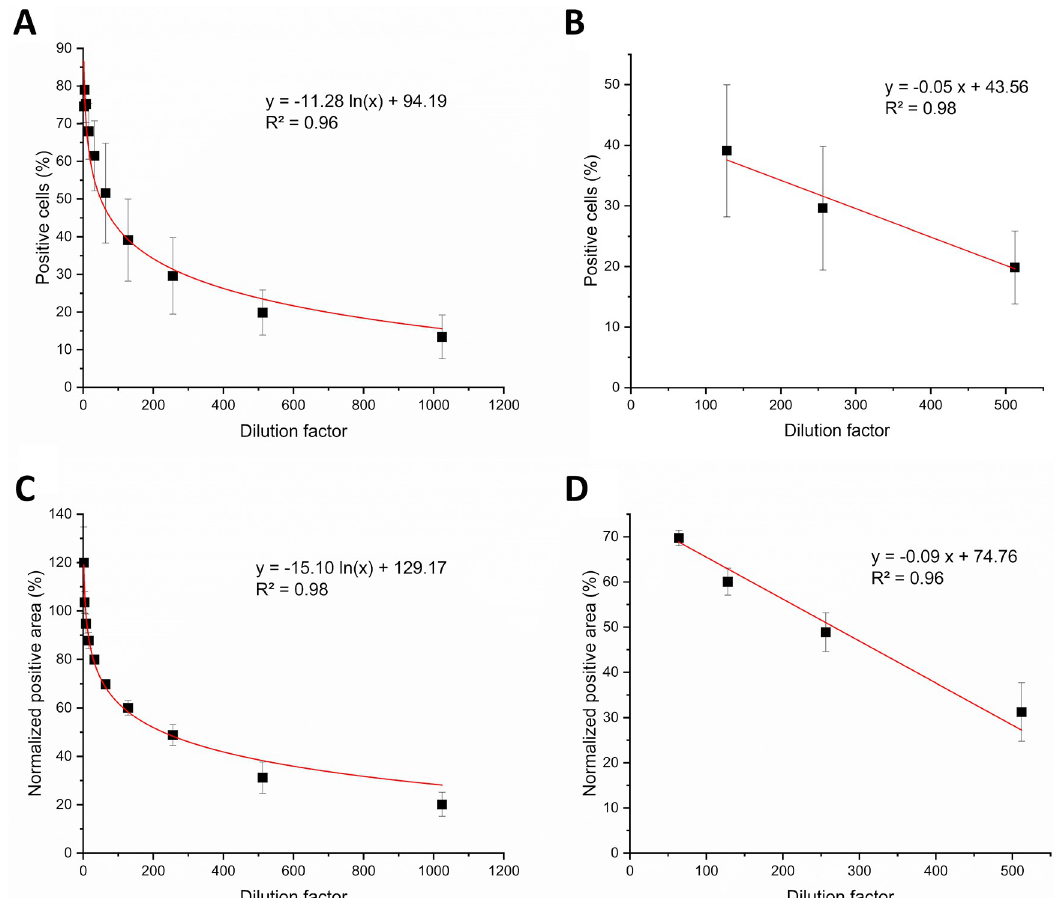
Fig 5. Linear range of the infectious titer assays. The number of positive cells detected via flow cytometry (A & B) and the FabFluor-488 positive area determined with the Incucyte 1 S3 (C & D) were plotted against dilution factors from a serially diluted lentiviral vector. A logarithmic trend was observed across the whole range of dilutions using the Incucyte 1 readout with an R 2 of 0.98 (C) and the flow cytometer readout with an R 2 of 0.95 (A). A linear dependence was determined for dilutions from 1:64 to 1:512 for the Incucyte 1 assay with an R 2 of 0.96 (D) and from 1:128 to 1:512 for the flow cytometer assay with an R 2 of 0.988 (B). Data represent the mean ± standard deviation of three biological